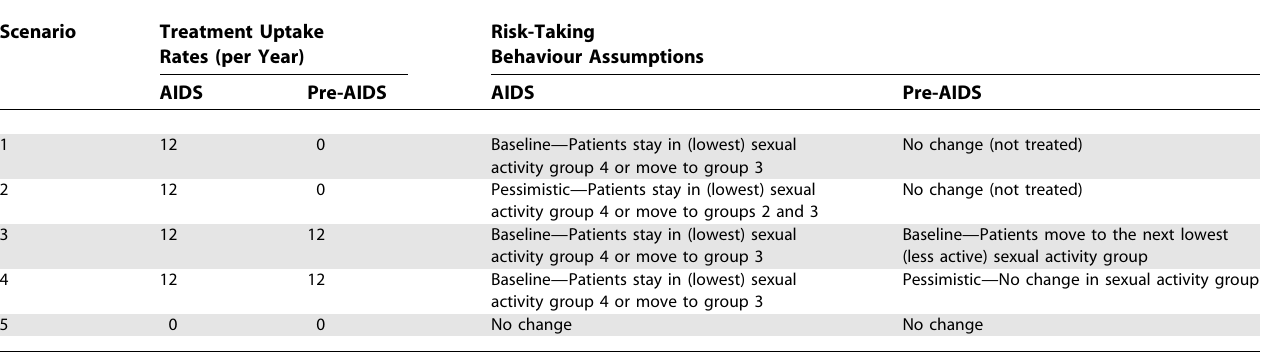
Table 3. Summary of Treatment Scenarios—Effect of ART on Various Epidemics: Changes in ART Patients’ Risk-Taking Behaviours Scenario